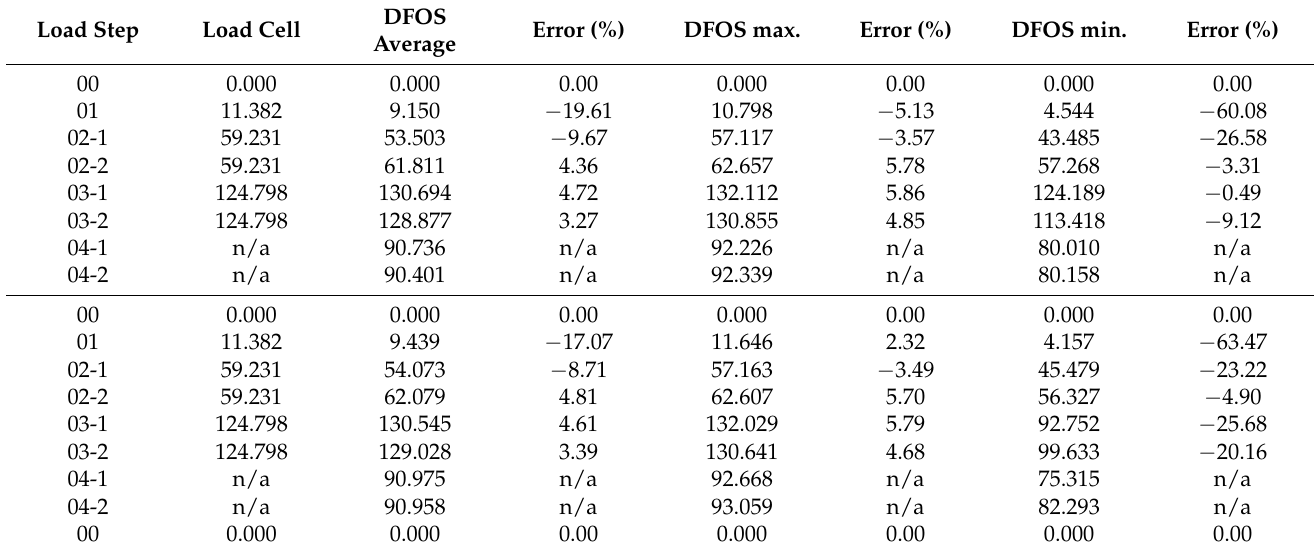
Table 7. Prestressing force monitored by load cell and DFOSs for PC2 (unit: